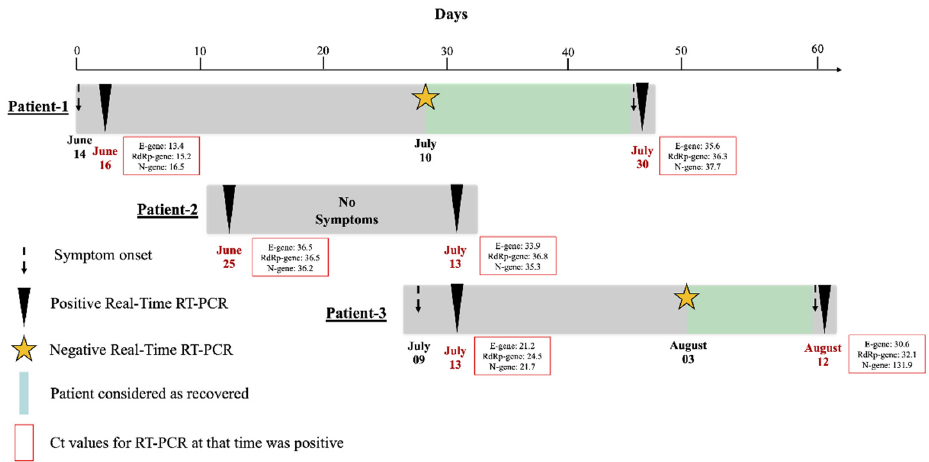
Figure 1. Epidemiological investigation in the three patients. Gray color indicates positive RT-PCR; green indicates a negative PCR. The epidemiological investigation was conducted in 2020. Nasopharyngeal swabs received in the laboratory from all three patients (six paired samples in total) were subjected to automated RNA extraction in an EX3600 Liferiver ® platform using the Viral RNA Isolation Kit, (Liferiver Bio-Tech, Shanggai, China) follow- ing the manufacturer’s instructions. The addition of an exogenous internal control com-